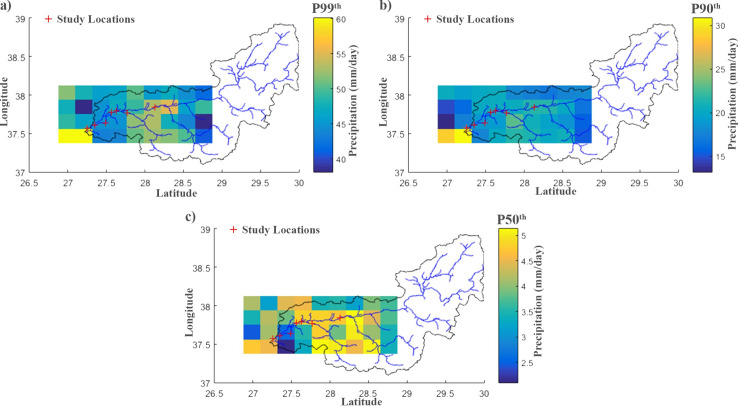
Spatial distribution of percentiles calculated from TRMM satellite data.(a) 99th percentiles calculated from TRMM satellite data. (b) 90th percentiles calculated from TRMM satellite data. (c) 50th percentiles calculated from TRMM satellite data.